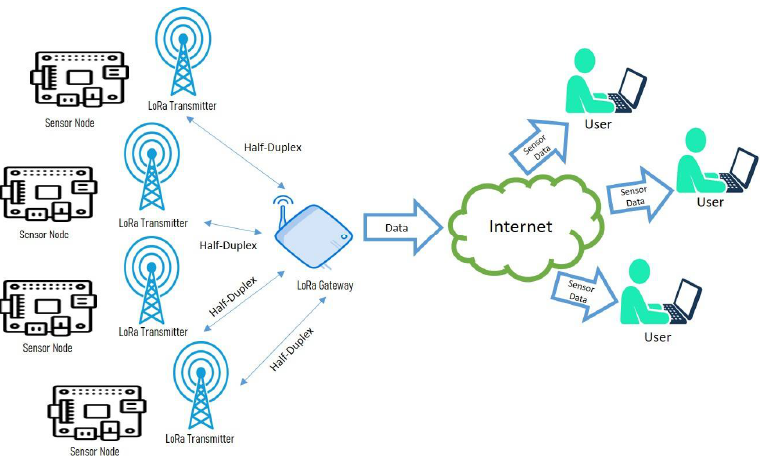
Figure 1. Internet of Things (IoT) based on Long Range Wide Area (LoRa) communications